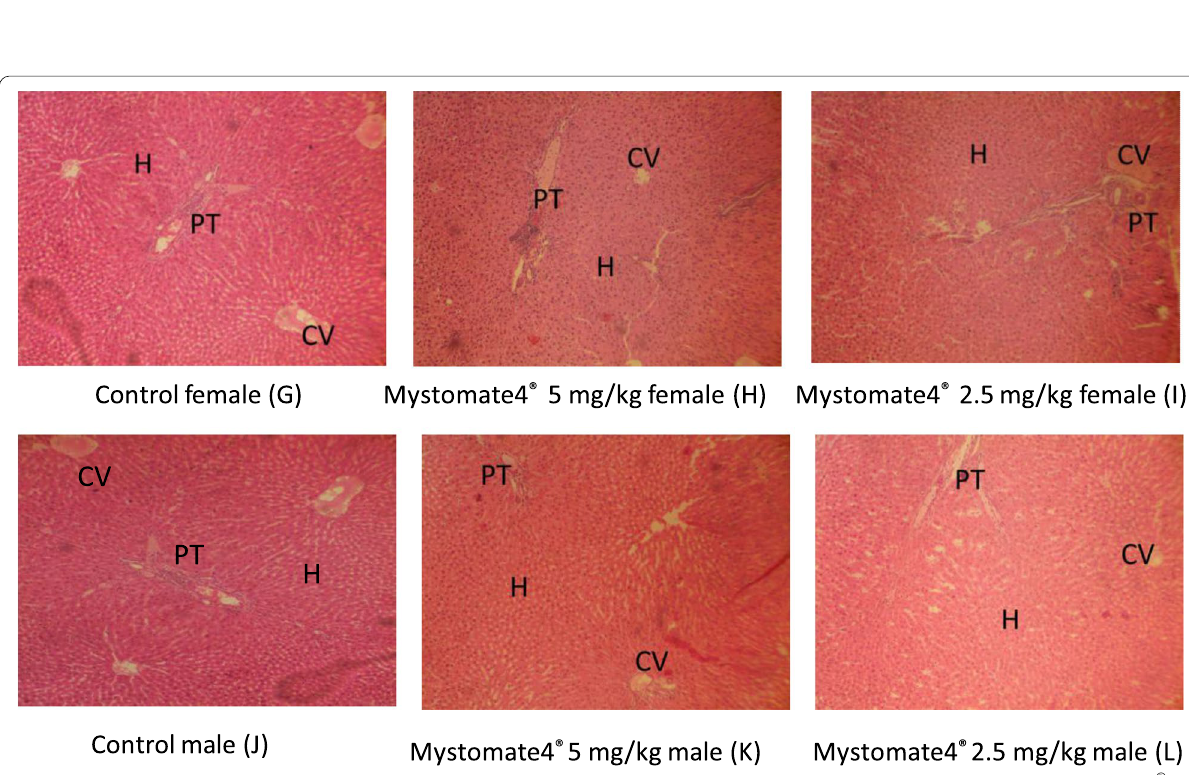
PT, central vein CV and hepatocyte = = =